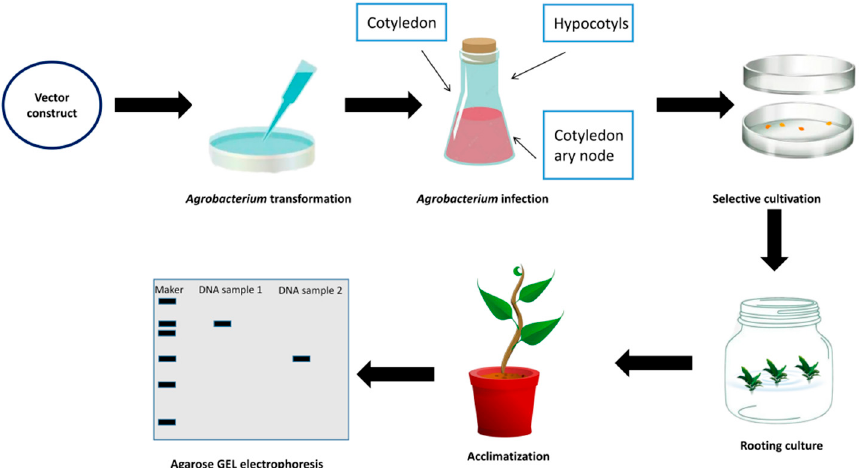
Figure 1. Schematic overview of Agrobacterium -mediated genetic transformation.